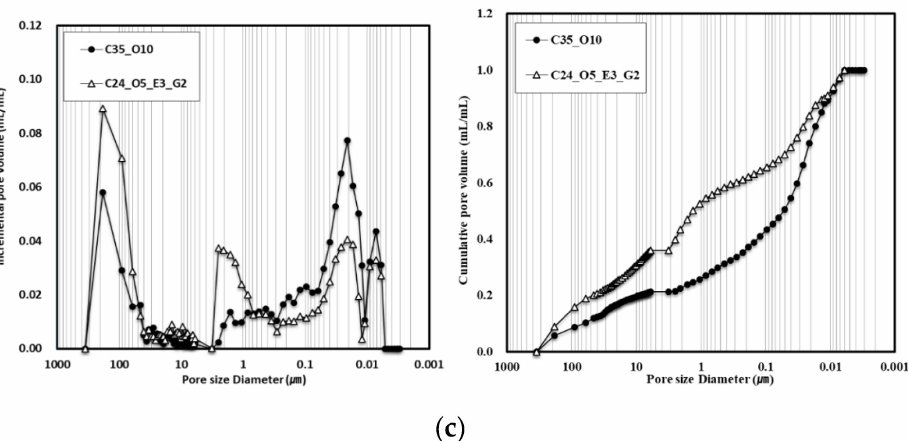
Figure 12. Pore structure according to mercury intrusion porosimetry: ( a ) 7 days; ( b ) 28 days; ( c ) 91